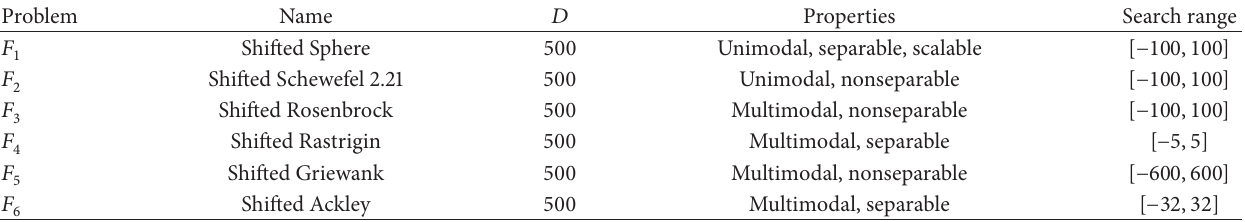
Table 5: The 6 shifted large-scale benchmark optimization problems proposed in [15].